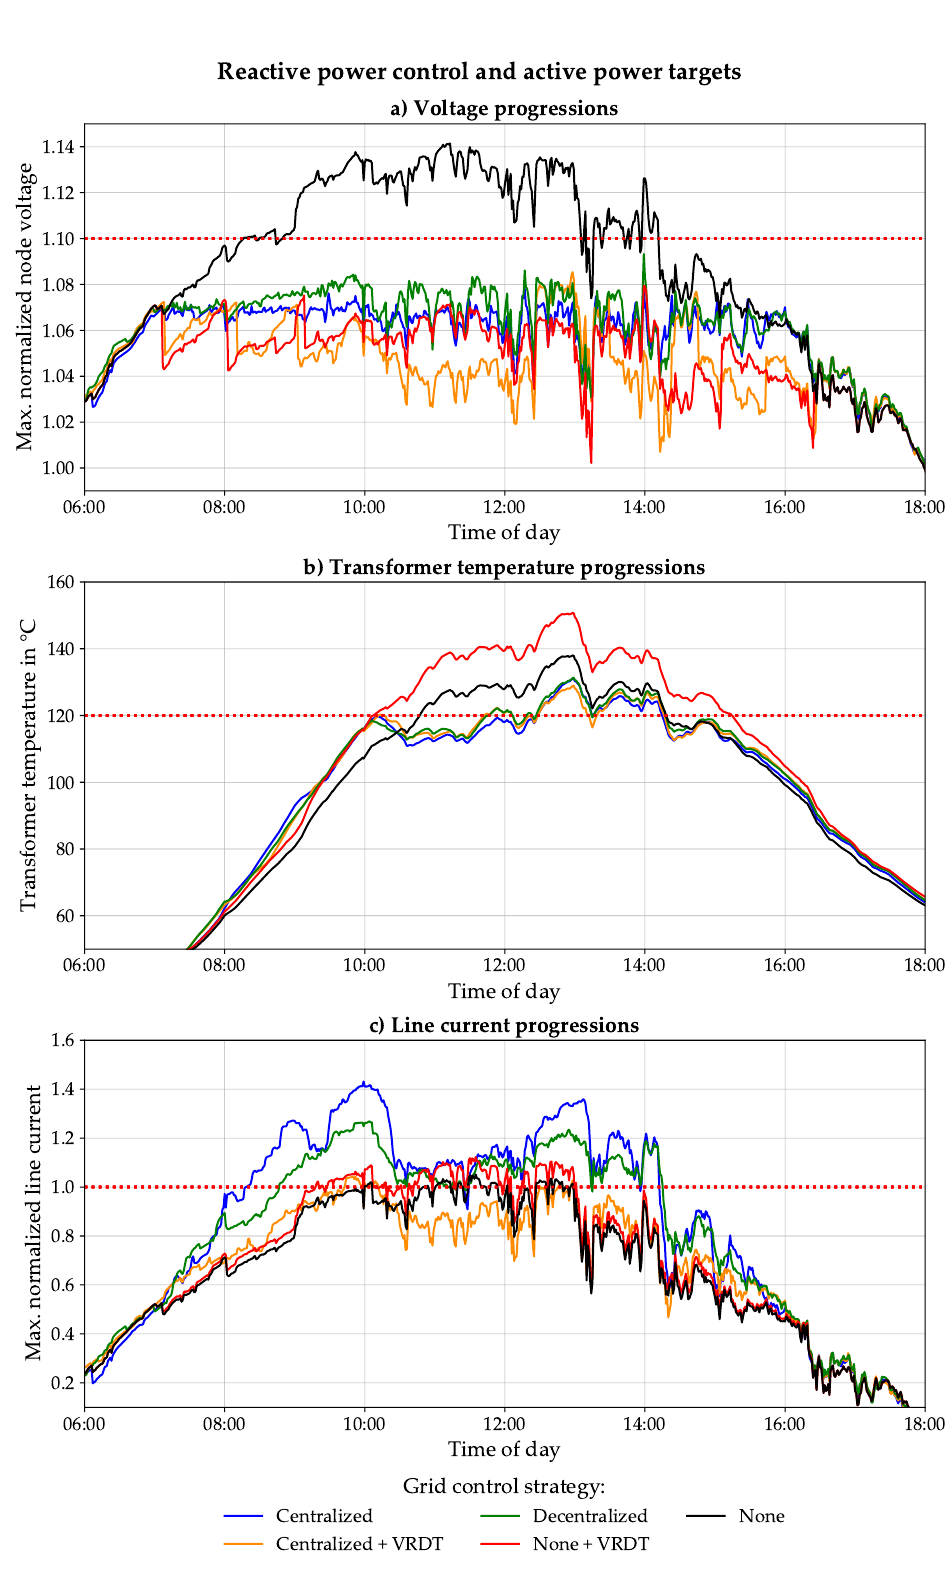
Figure 8. Performance comparison of the centralized and decentralized grid control strategies. Here, both reactive and active power flexibility are used. Grid status progressions without flexibility-based grid control are given as a reference. The simulated day is 1 July. For comparability, all progressions are based on the same random seeds. Maximum admissible values are indicated by red, dotted lines. ( a ) shows the progressions of the maximum node voltage in the grid. ( b ) shows the progressions of the transformer temperature. ( c ) shows the progressions of the maximum line current in the